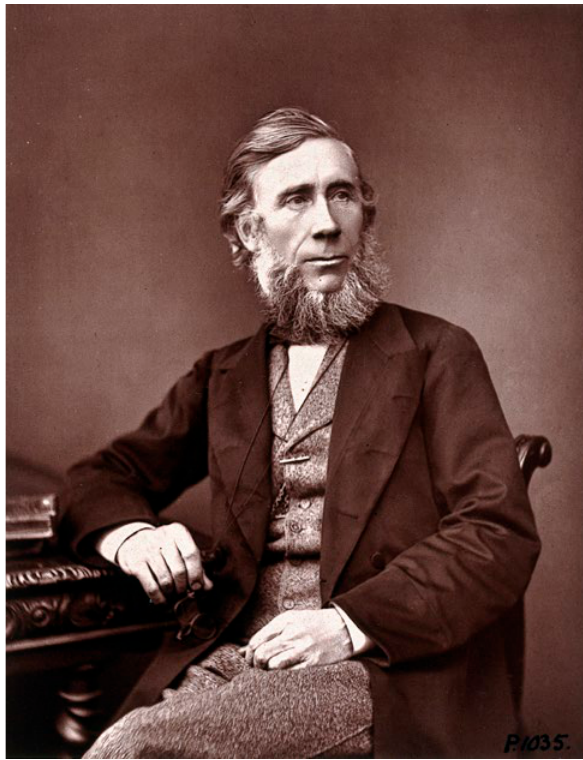
Figure 2. John Tyndall (1820–1893). Credit: Wellcome Collection, CC